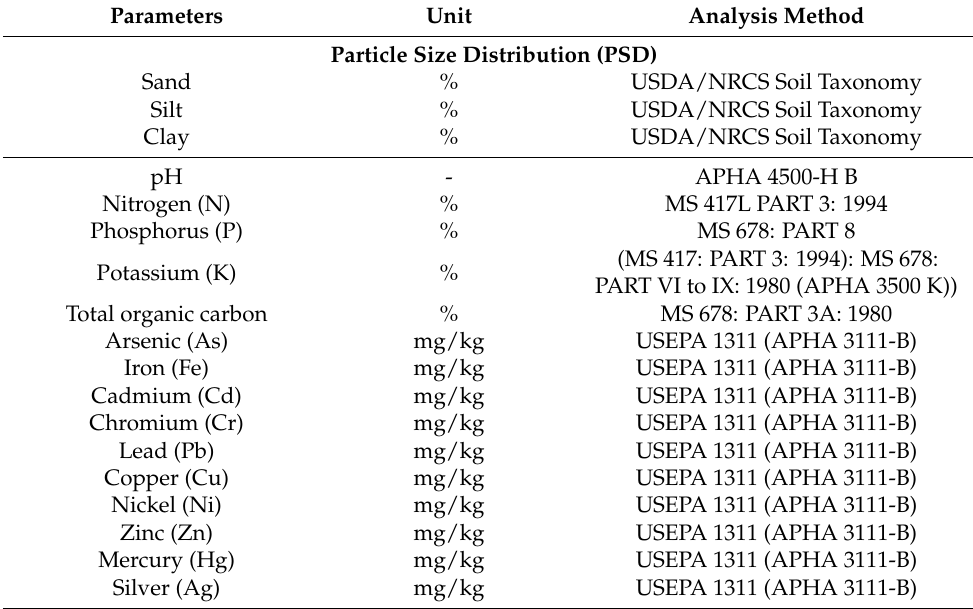
Table 6. Analytical method used for selected